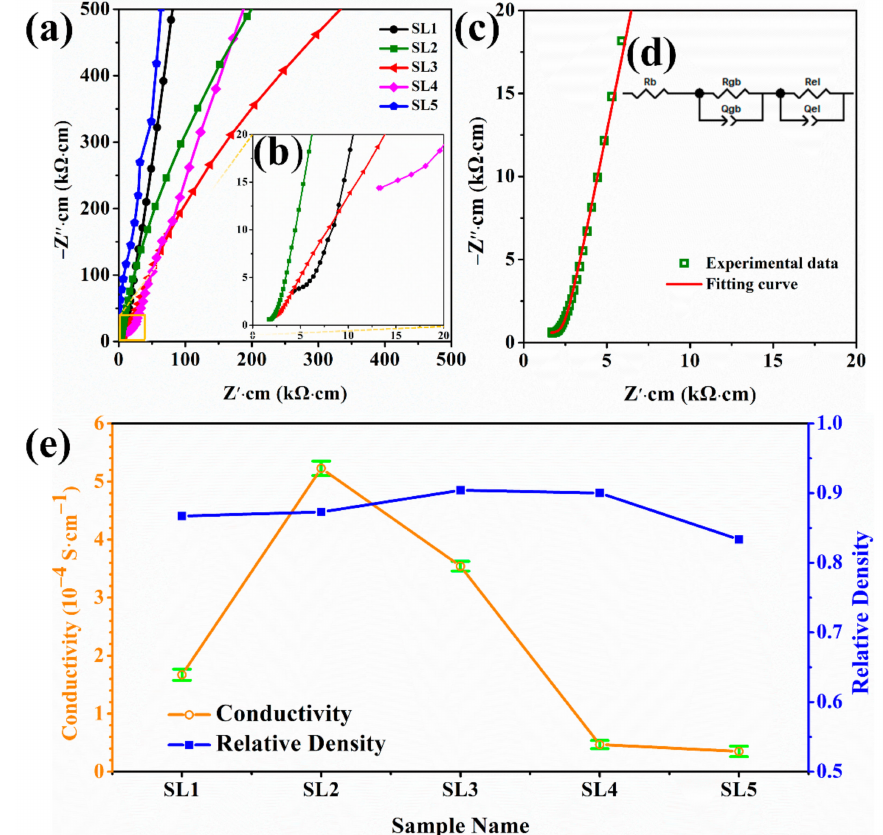
Figure 4. ( a , b ) AC impedance plots of the LLZNO ceramics with di ff erent sintering conditions at 25 ◦ C; ( c ) AC impedance plots and fitting curve of SL2 at 25 ◦ C; ( d ) equivalent circuit to fit the curves. ( e ) Total conductivity and relative density of the LLZNO